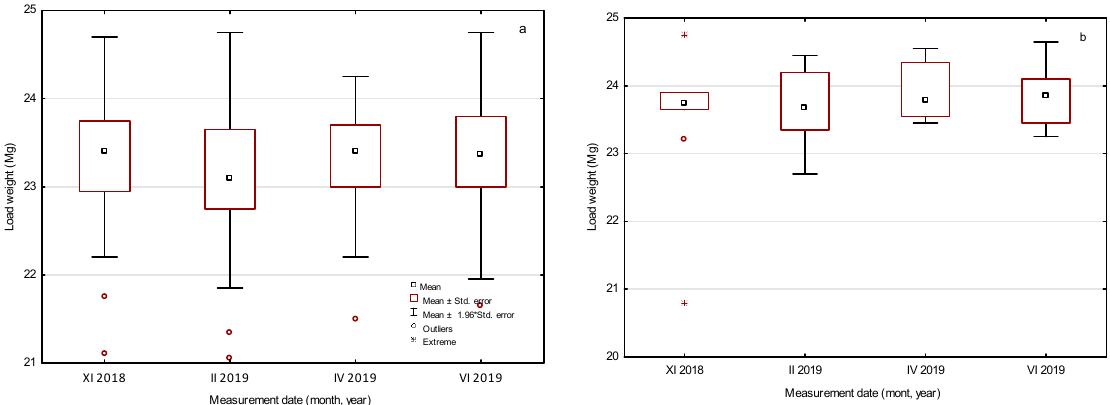
Figure 8. Comparison bulk volume of load values by measurement date for unit A wood chips ( a ); sawdust ( b ).